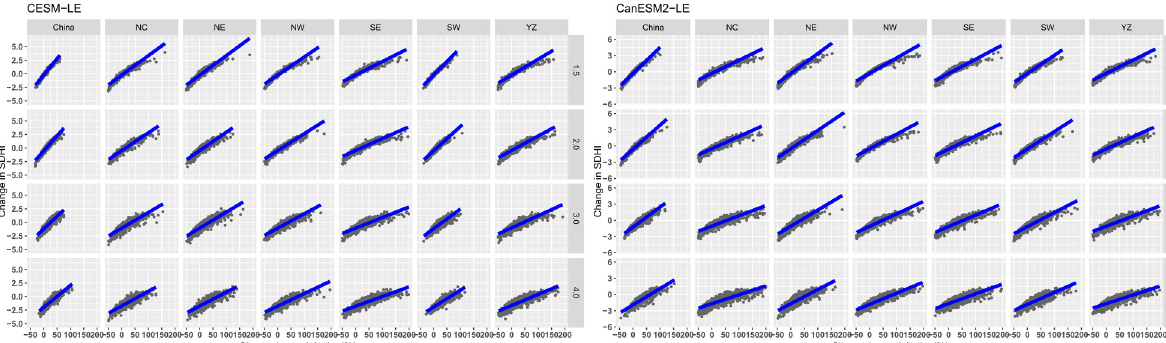
Fig 6. Same as Fig 5, but for the temperature changes and SDHI changes.